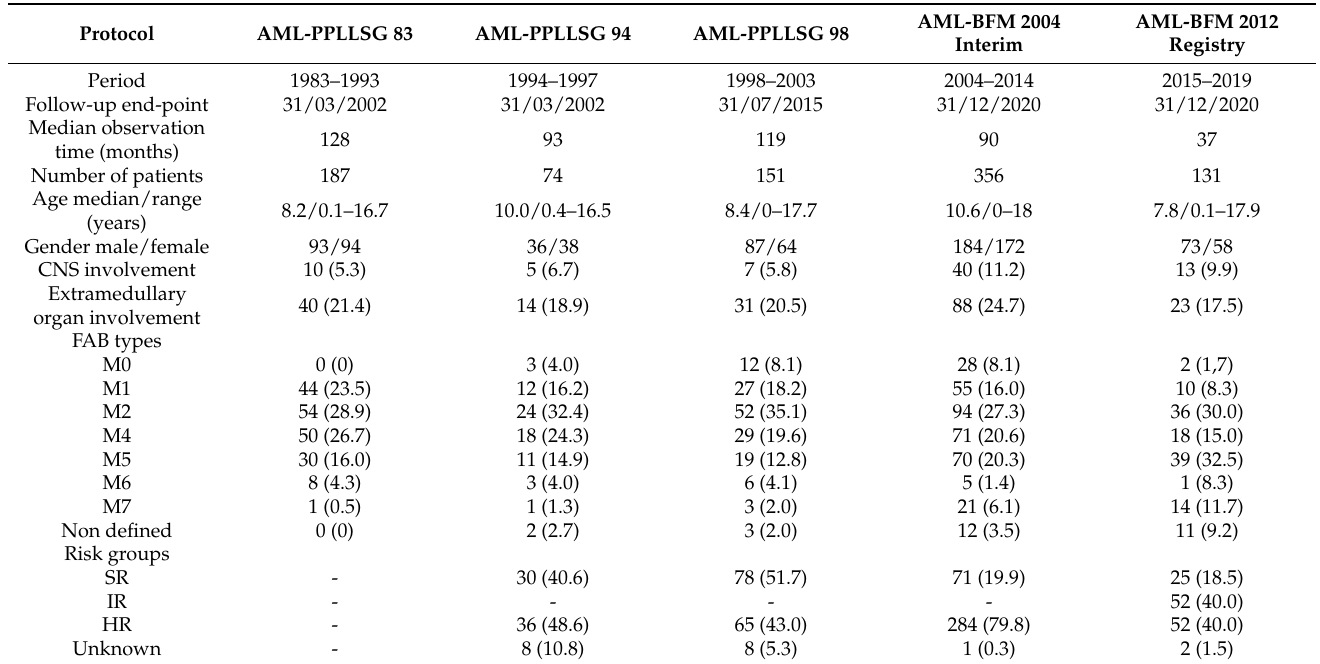
Table 1. The patient characteristics.